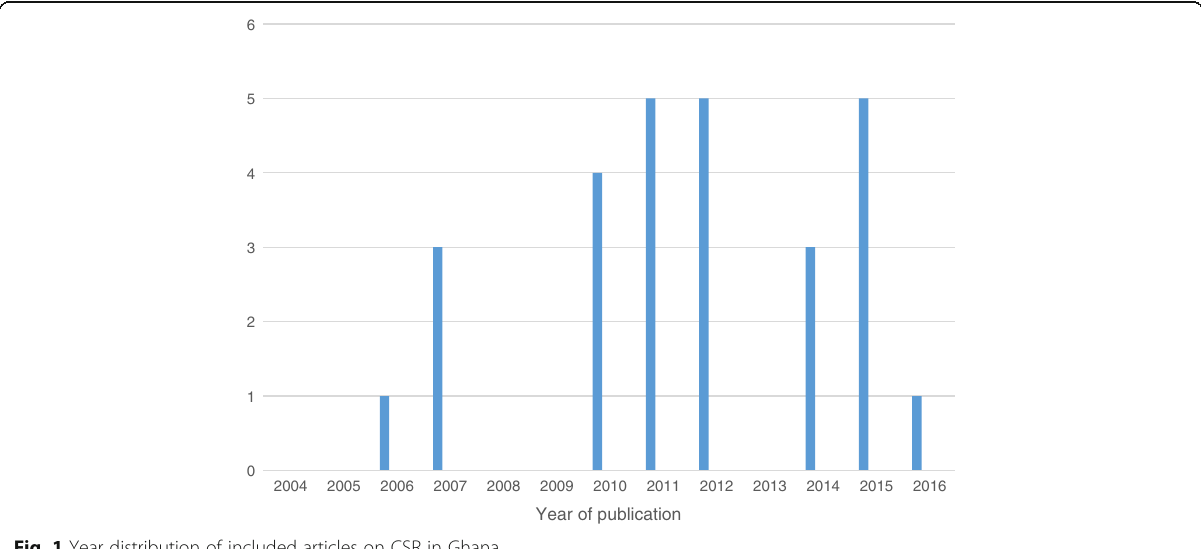
Fig. 1 Year distribution of included articles on CSR in